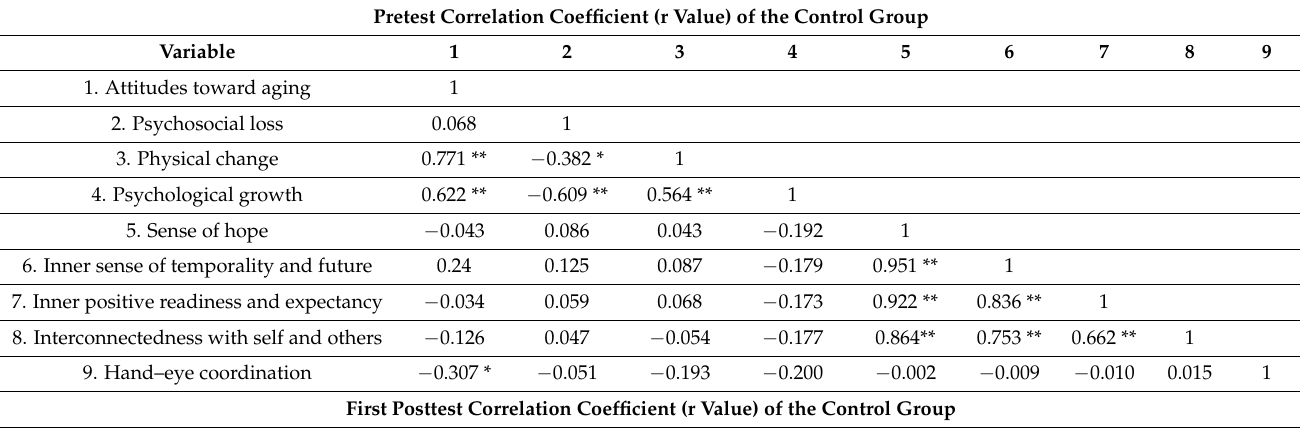
Table 5. Pearson product–moment correlation analysis of attitudes toward aging, sense of hope, and hand–eye coordination. Pretest Correlation Coefficient (r Value) of the Control